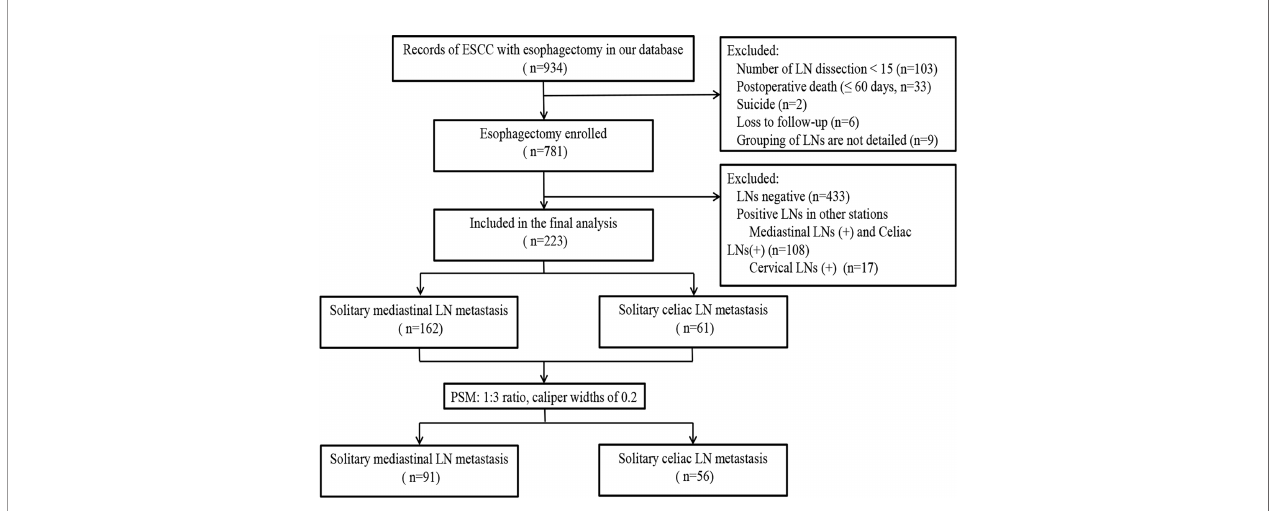
FIGURE 1 | Flowchart of patient inclusion, allocation, and analysis. In this study, 223 patients were enrolled. After PSM, 147 patients were available for outcome